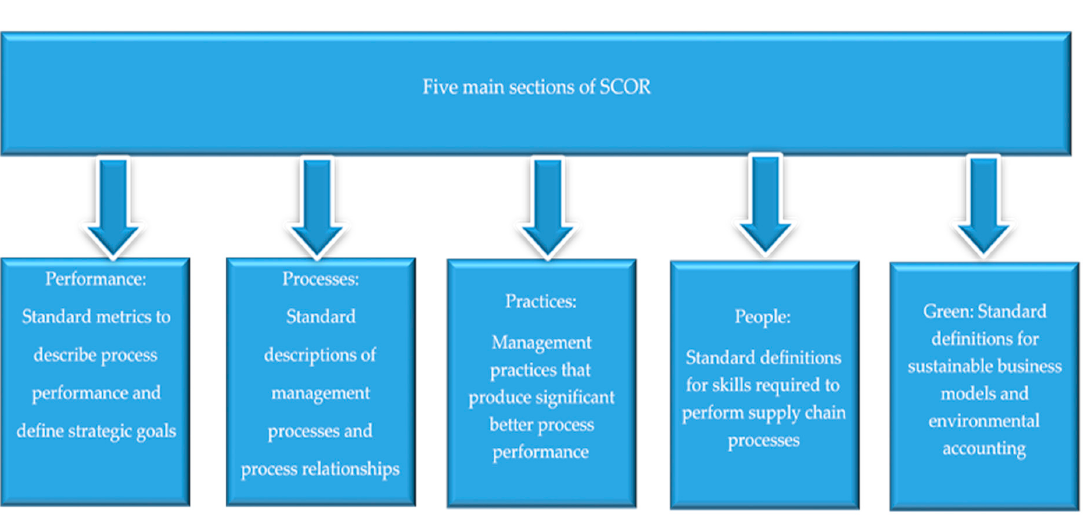
Figure 2. Five main sections of the SCOR.